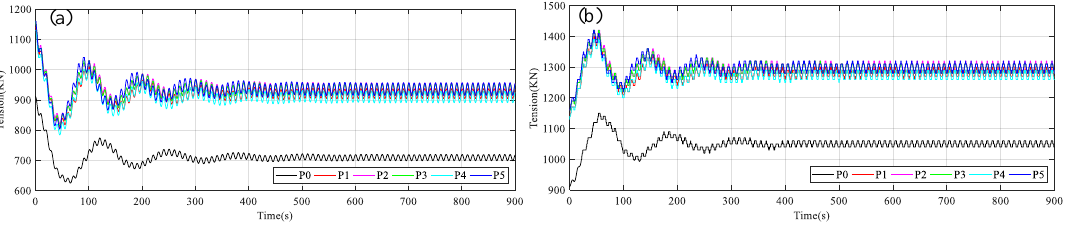
Figure 14. Fairlead tension in load case 1 for ( a ) fairlead 1, ( b ) fairlead 2.